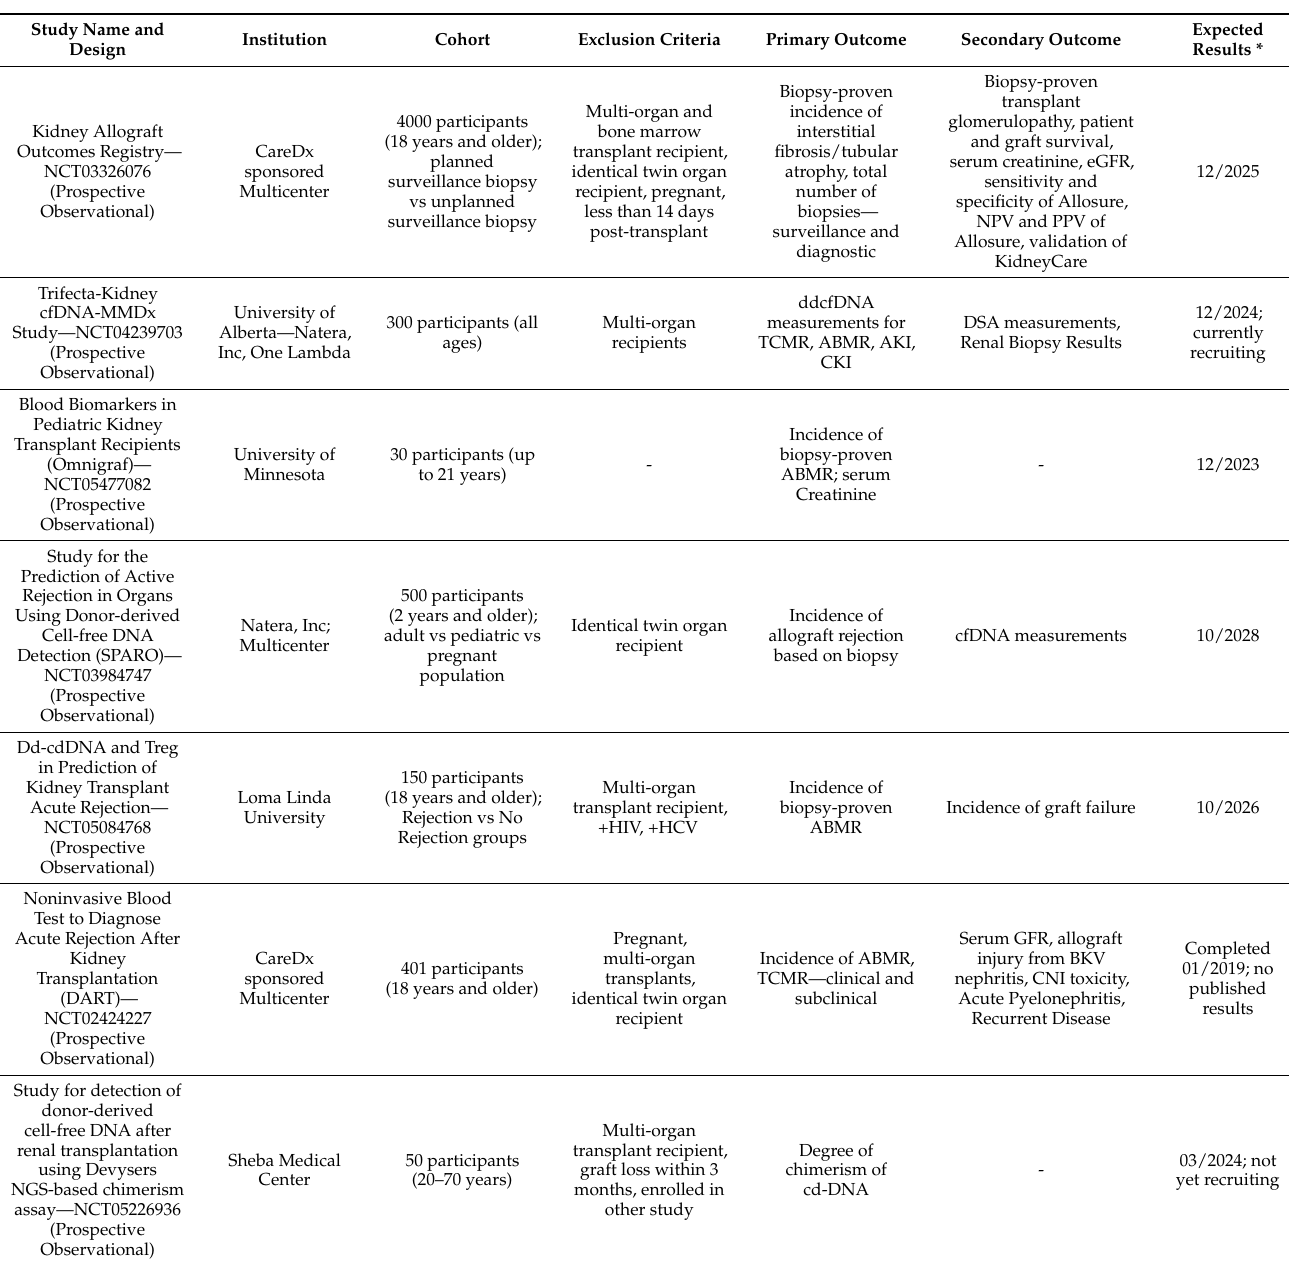
Table 2. Current clinical trials investigating